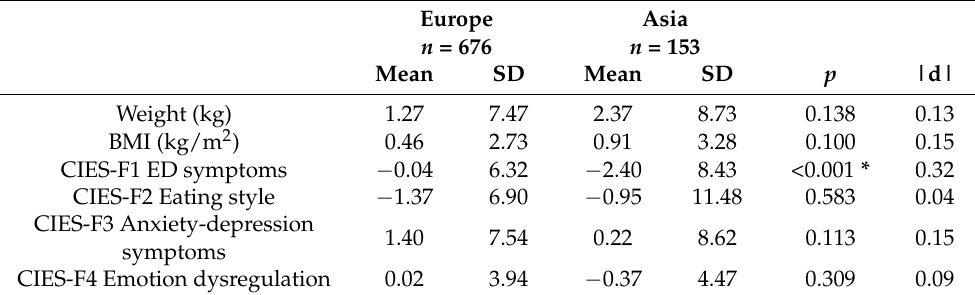
Table 6. Comparison of the post-pre differences by